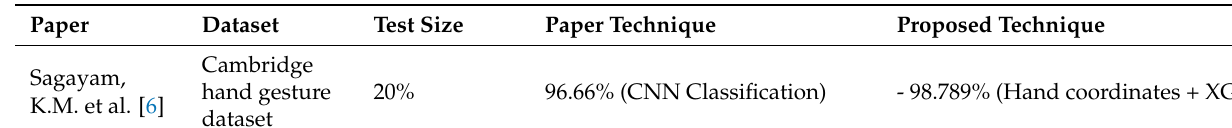
Table 14. Results